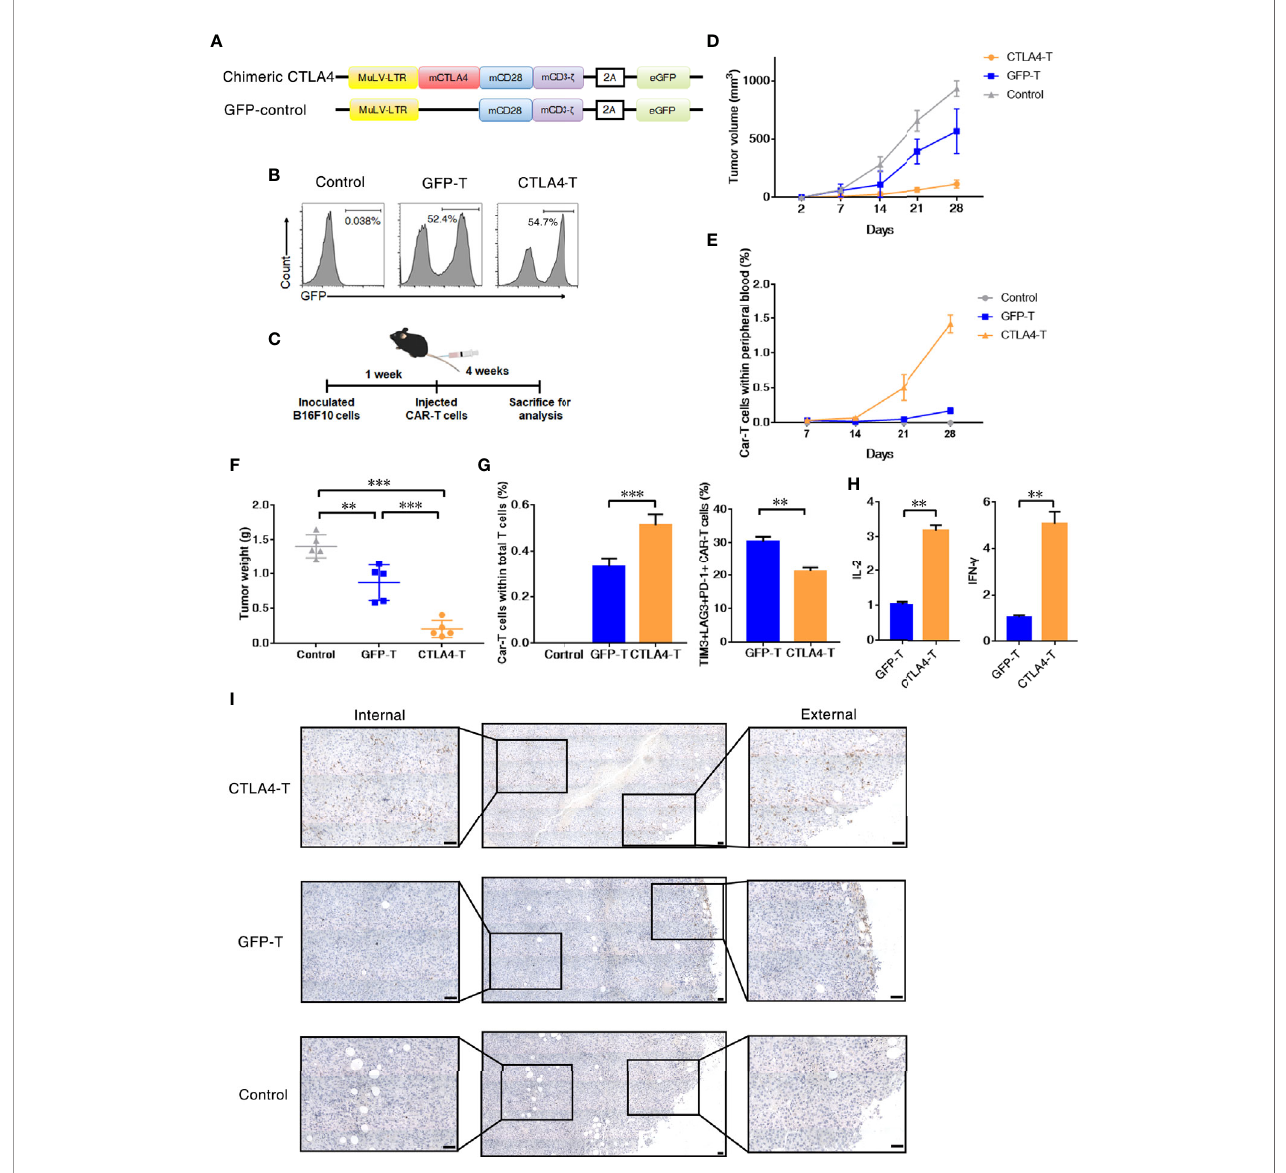
FIGURE 3 | T cells expressing the CTLA4-CD28-CD3z chimera had effective tumor in fi ltration. (A) Murine chimeric CTLA4 molecules contained the extracellular and transmembrane domains of mouse CTLA4, the cytoplasmic region of mouse CD28, and the intracellular domains of mouse CD3z. T cells expressing GFP were constructed as the control group. (B) Representative fl ow cytometric analysis of murine chimeric CTLA4 or GFP expression in mouse T cells. (C) Experimental scheme for evaluating murine CTLA4-CAR T cells ef fi cacy, 2 × 10 5 of B16F10 cells were subcutaneously transplanted, and mice were intravenously administered T cells transduced with either chimeric CTLA4 or GFP or PBS (Control), fi ve mice/group. (D) The tumor volumes in the mice were measured and calculated every 7 days. (E) The percentages of CAR T cells in peripheral blood of the mice were measured and calculated every 7 days. (F) The B16F10 tumor weight was weighed after 35 days, mean ± SD, one-way ANOVA. (G) The percentages of CAR T cells in total in fi ltrated T cells within the tumor tissues, and the percentages of TIM3+LAG+PD-1+ CAR T cells, mean ± SD, one-way ANOVA. (H) qRT-PCR analysis of the mRNA expression of the indicated genes. The results were normalized to glyceraldehyde 3-phosphate dehydrogenase (GAPDH) mRNA levels and are presented as the mean ± SEM (n = 3), unpaired two-tailed t-test. (I) Immunohistochemical staining identi fi ed the in fi ltrated CAR T cells in resected tumors, GFP+ cells were stained. Signi fi cance values: ** P < 0.01; *** P <